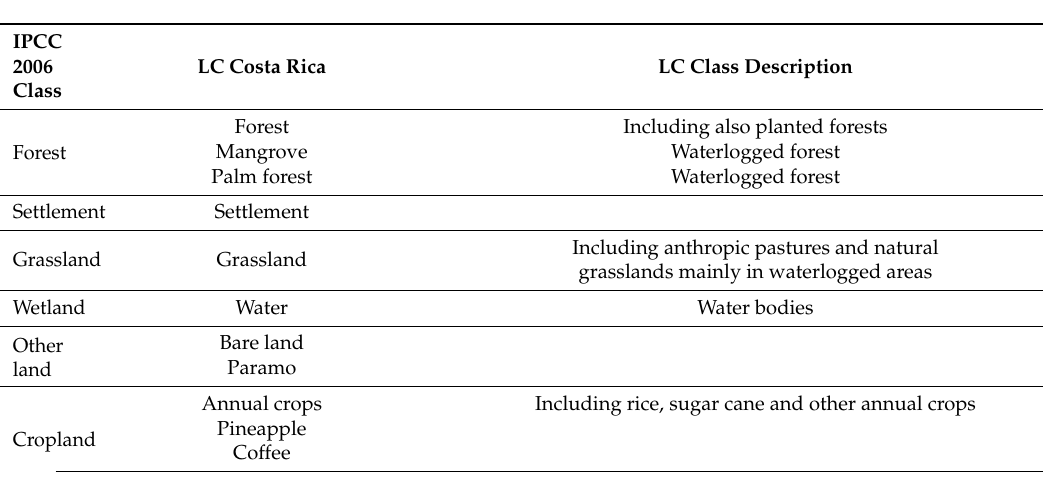
Table 1. Comparison between the Land Use Categories considered in IPCC (2006) and the classes considered in the Land Cover (LC) Classification in Costa Rica for the years 1997/1998, 2007/2008, 2011/2012 and